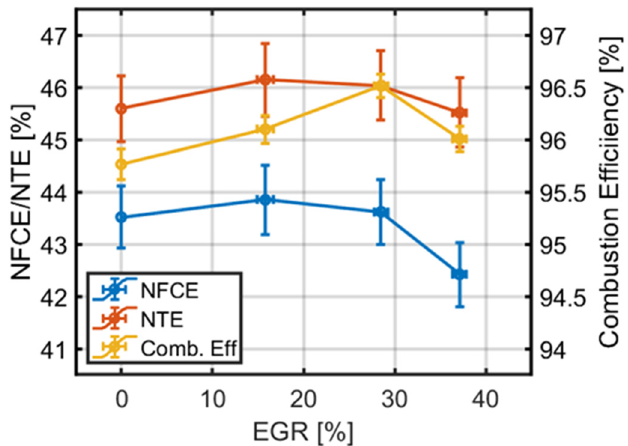
Figure 8. Net fuel conversion (FC) efficiency, net thermal efficiency, and combustion efficiency vs. external, cooled exhaust gas recirculation (EGR).